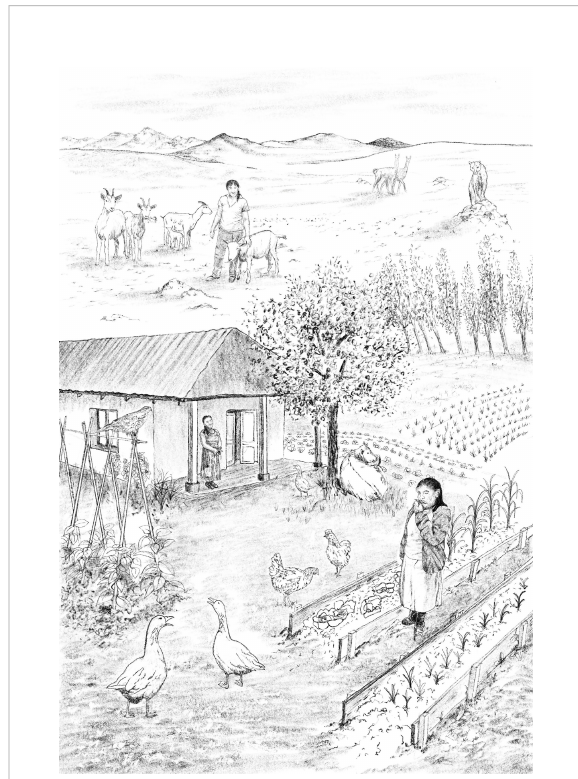
FIGURE 1 “ Private life of feminine rurality ” , illustration by Mar ı ́ a de los A ́ ngeles Medina inspired by the spaces of intimacy between women and their animals, and between women and the social – ecological landscape. This naturalistic illustration shows how women dwelling on their spaces of silence and privacy develop traditional and local knowledge. From contemplation and action, they learn about animals and plants. They do this on their own and with their neighbors. This constant horizontal and intimate interaction makes them empathetic and sensible observers and guardians of our relationship with biodiversity and its life